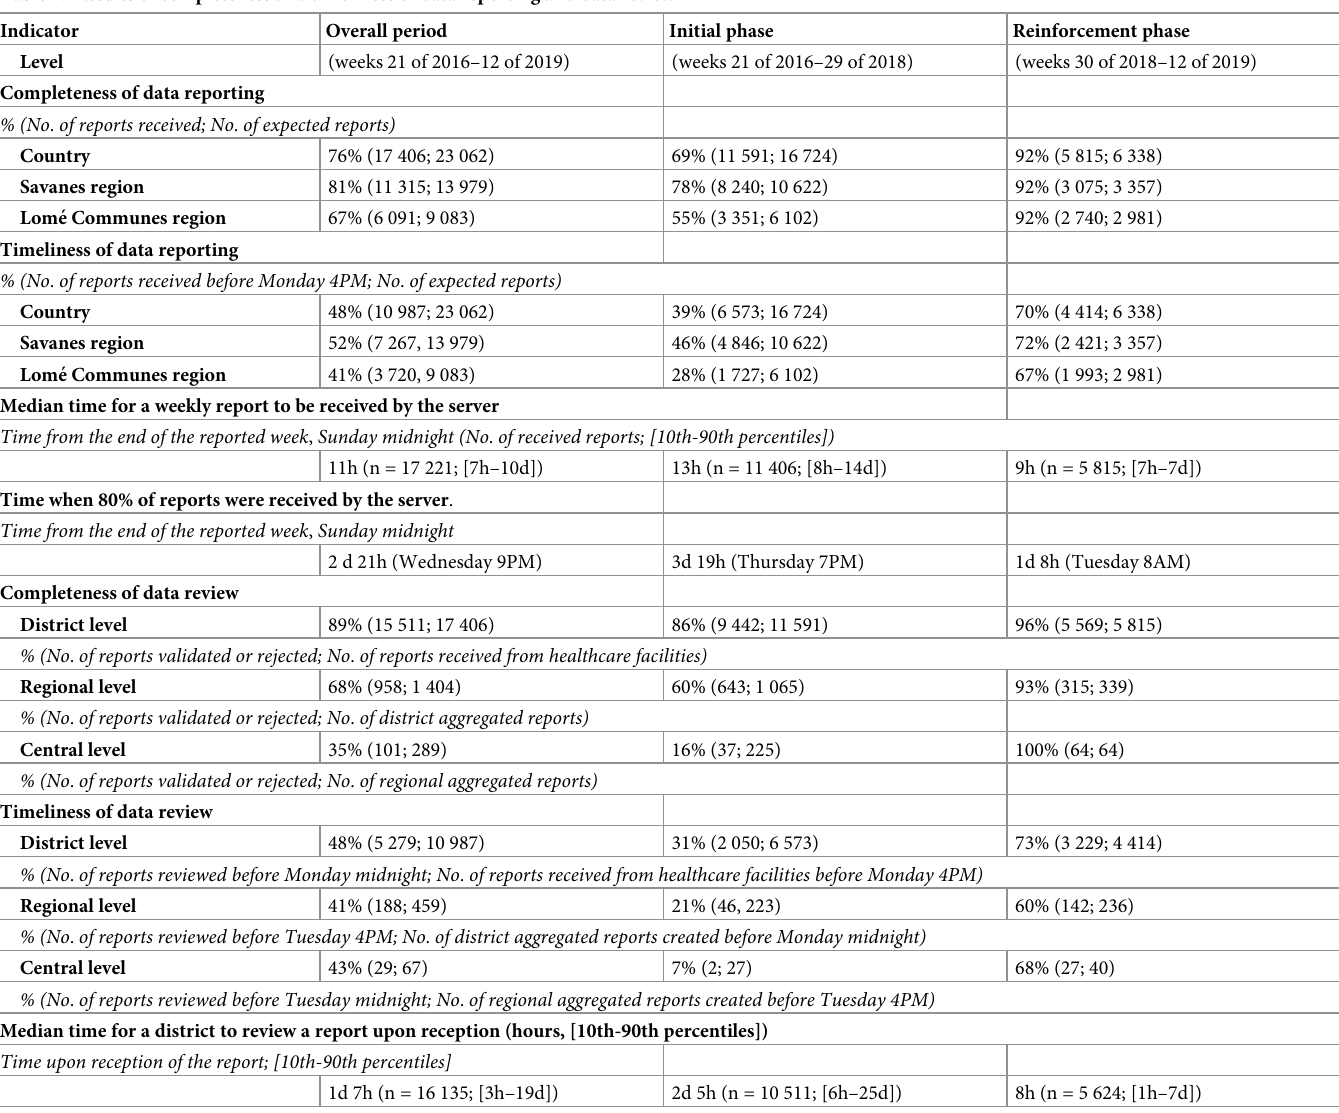
Table 2. Results of completeness and timeliness of data reporting and data